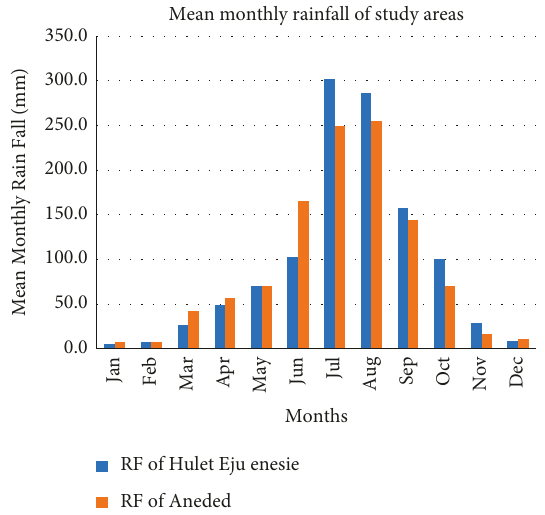
Figure 2: Mean monthly rainfall of the study areas. Source: ARMA (2019) for climatic data.